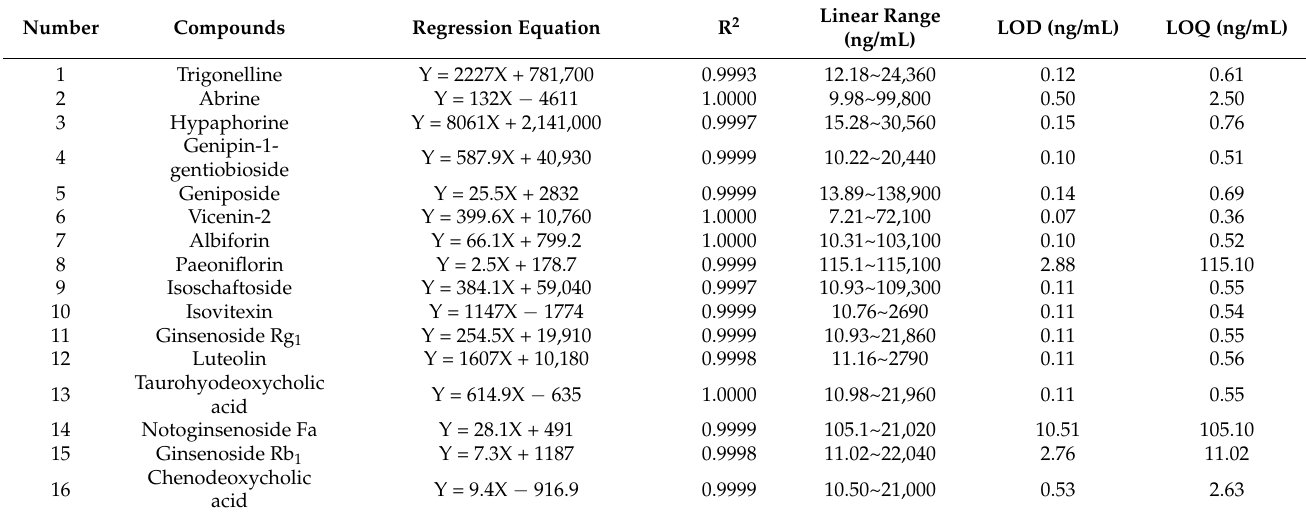
Table 3. Regression equation, linear range, LOD and LOQ of the 16 active ingredients in